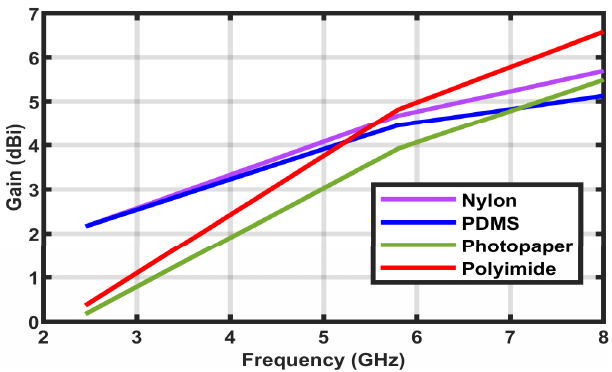
Figure 16. The return loss of the antenna for different substrate materials.